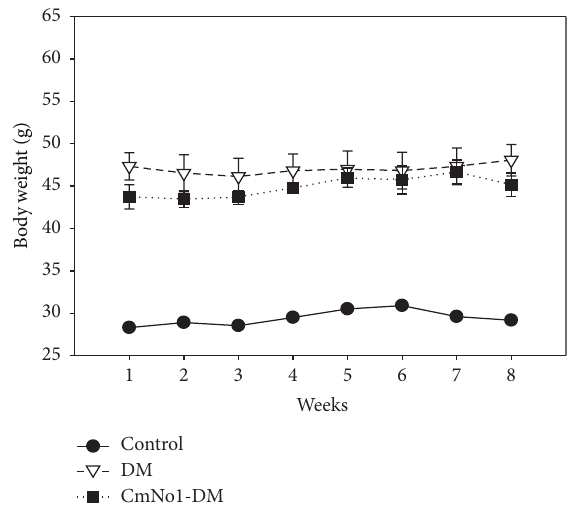
Figure 3: Maintenance of body weight. Body weight in control ( e ), type 2 diabetes mellitus (DM) ( 󳶚 ), and CmNo1-treated DM (CmNo1-DM) ( ◼ ) mice was examined. Mice were first exposed to high-fat diet (HFD) for six months to induce C57BL/6J mice with type 2 DM, which were then treated with CmNo1 for eight weeks. The body weight of all three groups was recorded to note any significant change. Data is expressed as the means ± SEM ( 𝑛 = 6 /group).